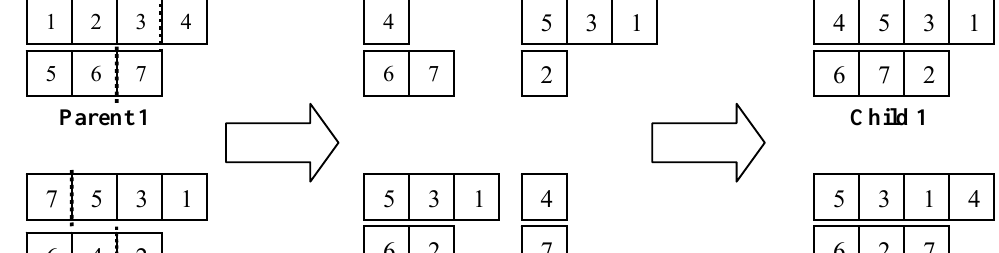
Fig. 1. An example of crossover